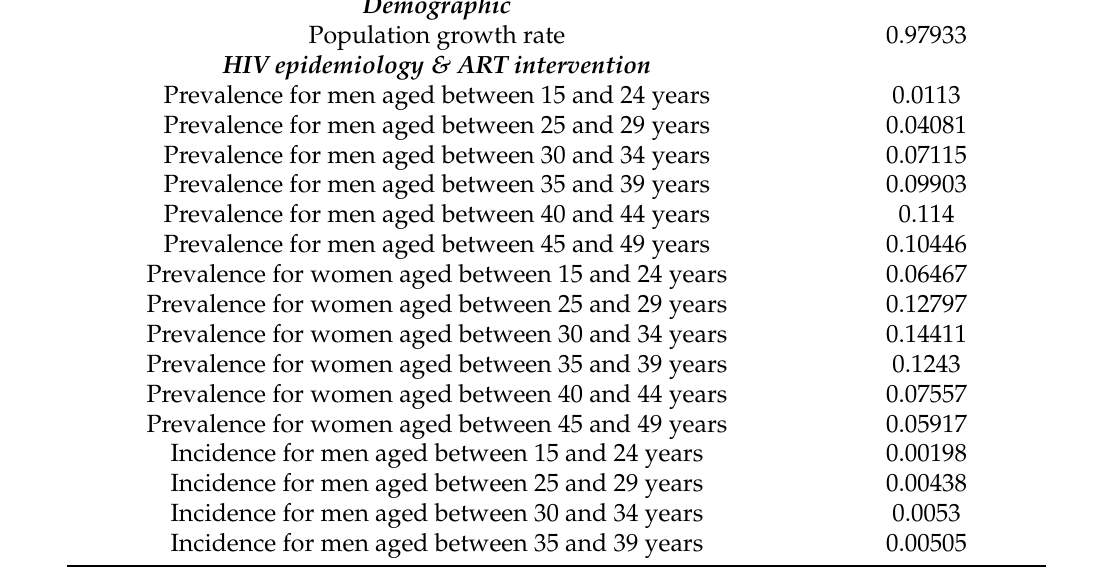
Table A5. Mean values of epidemiological and behavioural summary features from benchmark